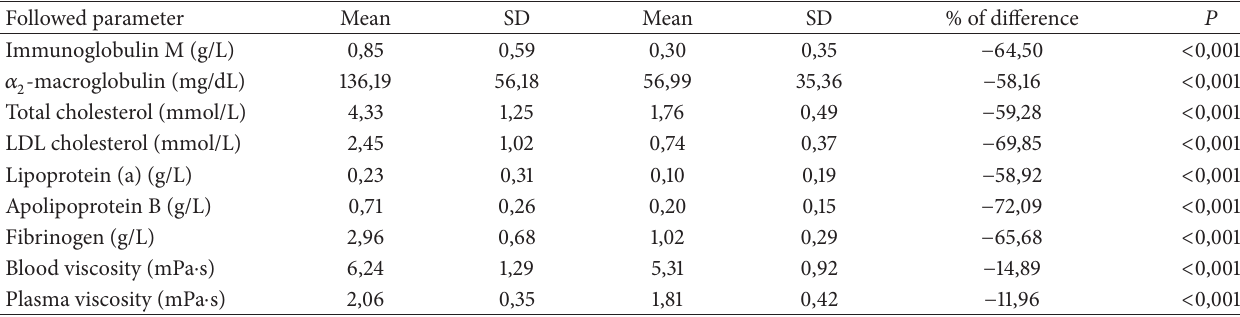
Table 4: Indicators of rheological